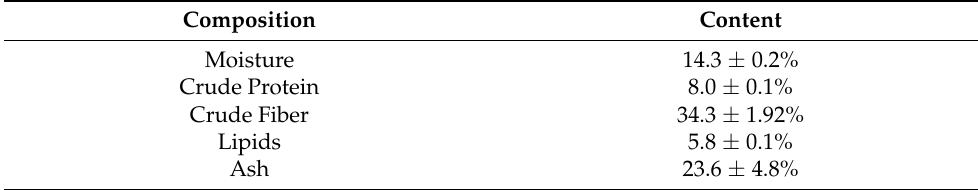
Table 1. Moisture (% fresh weight) and nutrient composition (% dry weight) of Crithmum maritimum L. (May). All the determinations were performed in triplicate. Results are expressed as mean ±